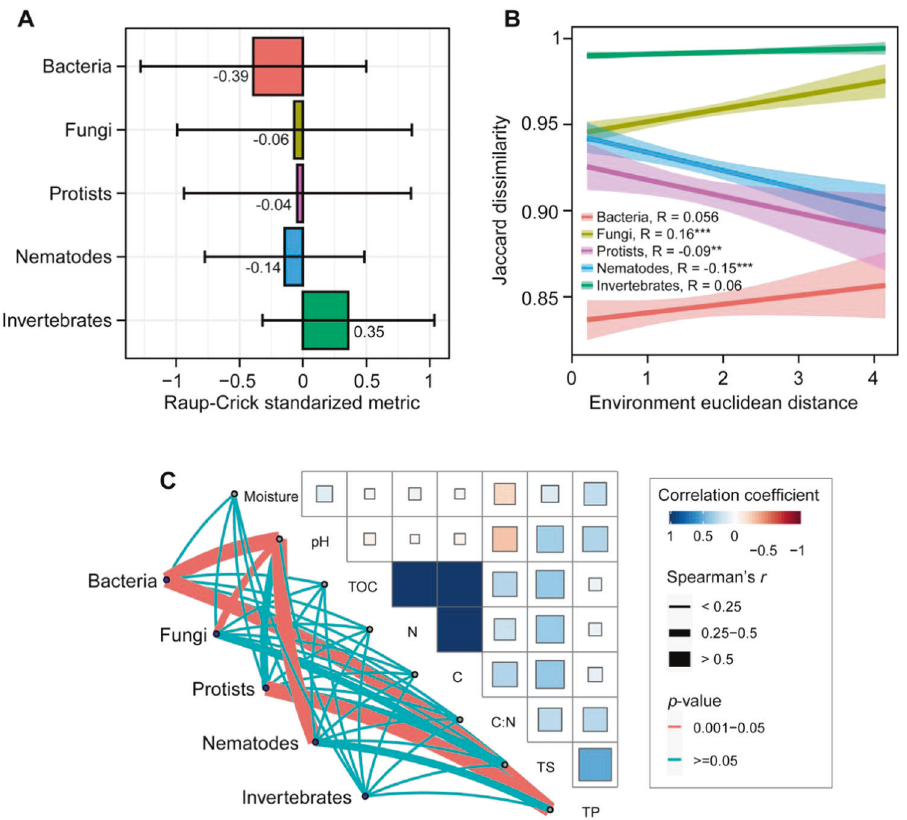
Fig. 4 The results of standardized Raup-Crick metric of beta diversity of different taxonomic groups of soil biota and their relationships with environmental gradient. A Positive and negative values indicate higher and lower deviations from the null model, respectively. The values near − 1 indicate homogenizing dispersal, the values between − 0.95 and 0.95 indicate drift and values near 1 indicate environmental selection. B Linear relationships between beta diversity of the studied taxonomic groups with the Euclidean distance of environmental variables. C Correlation between beta diversity of different taxonomic categories with environmental